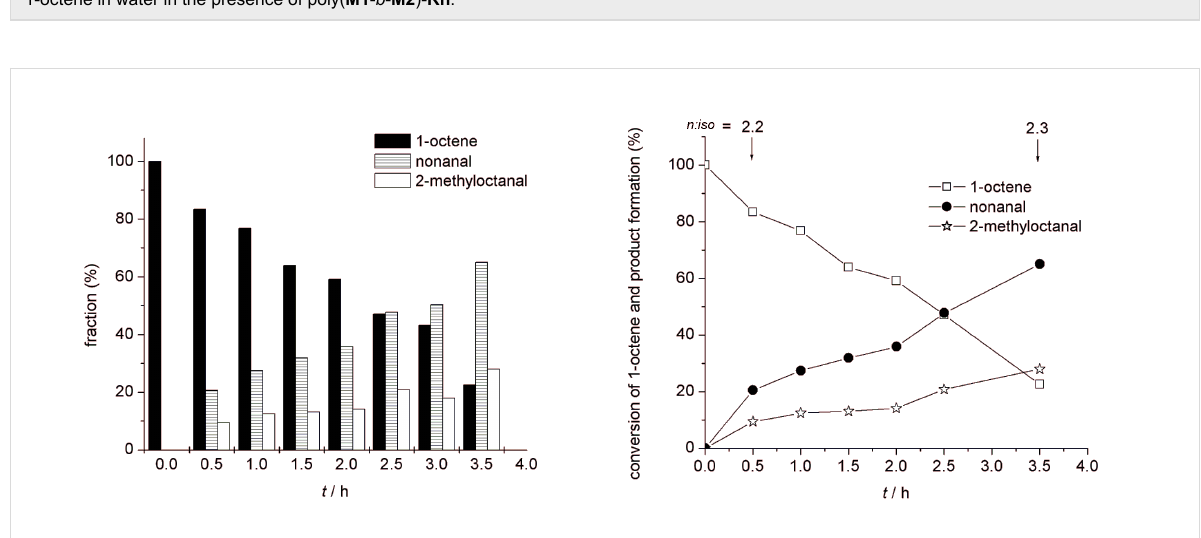
Figure 2: Conversion of 1-octene, product formation and product distribution in the hydroformylation in water in the presence of poly( M1 - b - M2 )- Rh and